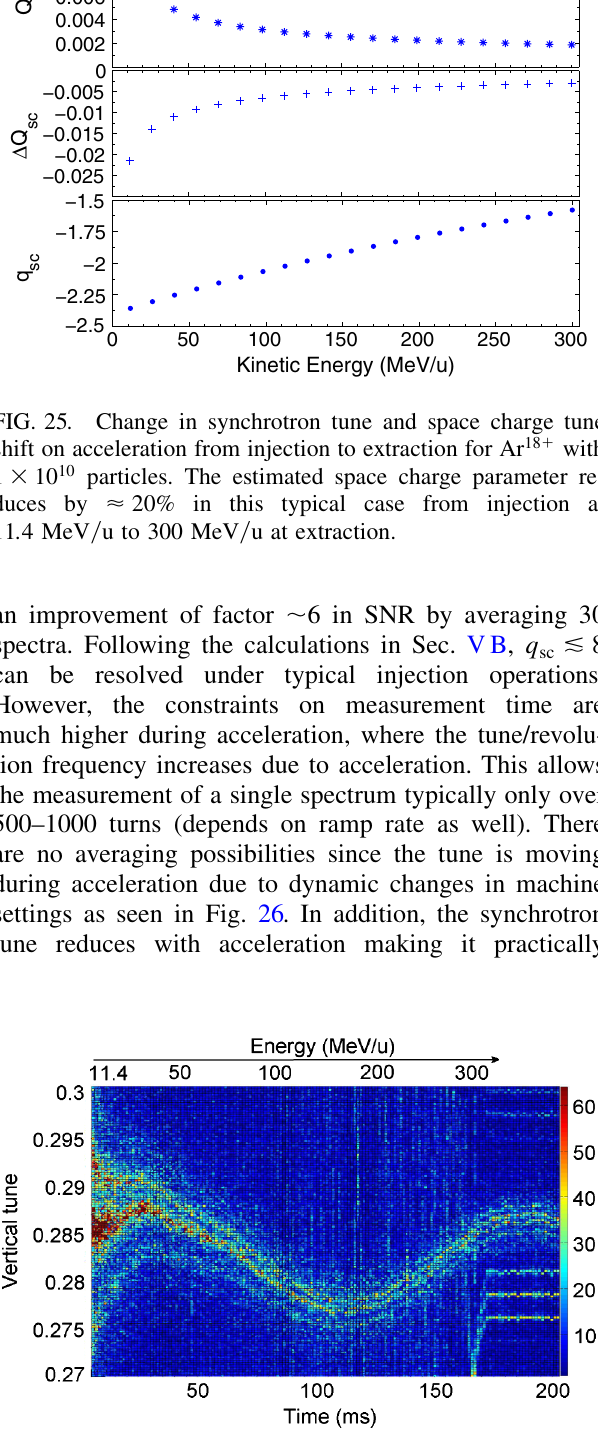
FIG. 26. The movement of head-tail modes during accelera- tion. The head-tail modes are getting closer since the synchro- tron tune reduces with acceleration, but the asymmetry of the k ¼ 1 and k ¼ (cid:1) 1 modes around k ¼ 0 is maintained through- out the ramp which depends primarily on the space charge parameter ð q sc Þ